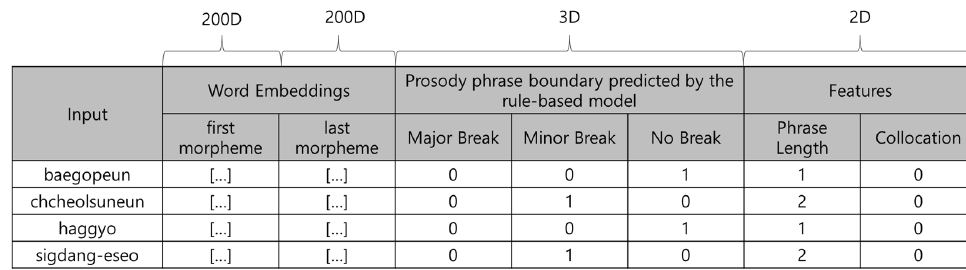
Figure 5. Structure of eo-jeol embeddings.